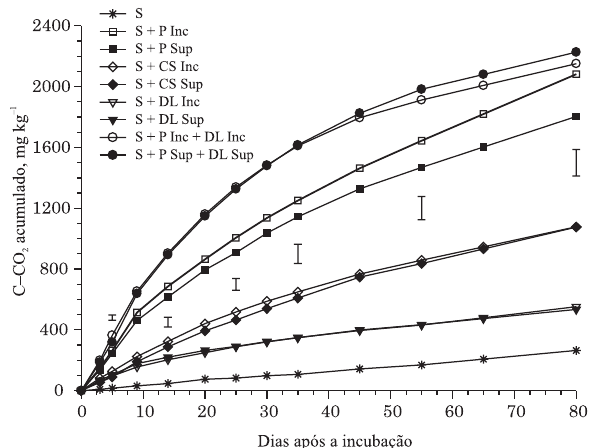
Figura 2. Quantidades acumuladas de C mineralizado do solo (S) e da palha de aveia (P), dos dejetos líquidos (DL) e da cama sobreposta (CS) utilizados isoladamente ou em conjunto, na superfície (Sup) ou incorporados (Inc) ao solo. As barras verticais representam a diferença mínima significativa entre as médias de cada tratamento (Tukey a 5